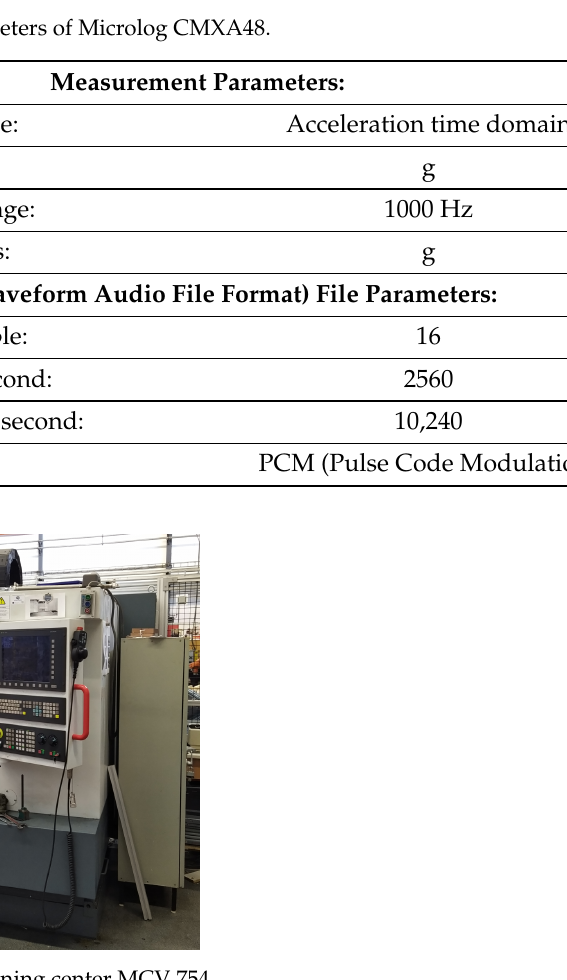
Figure 1. CNC vertical machining center MCV